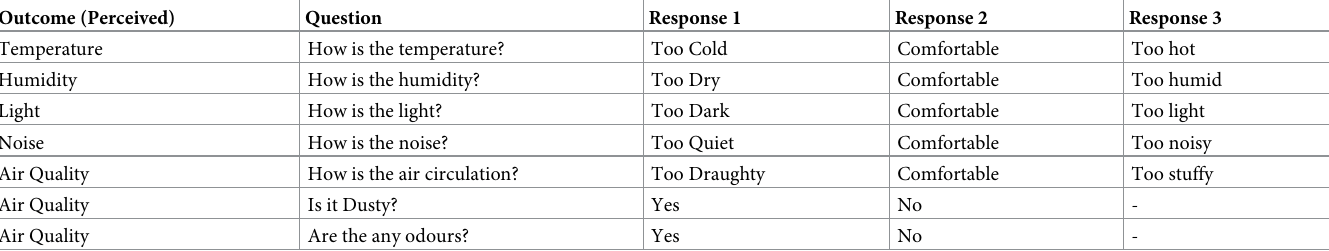
Table 3. Automated survey questions and